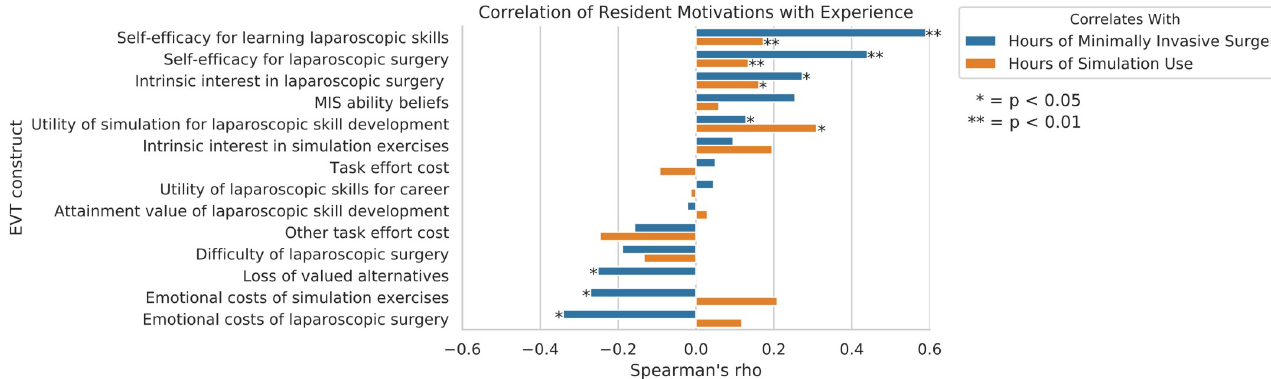
Fig 2. Spearman’s rho correlations between expectancy-value constructs, simulation use, and surgical experience.